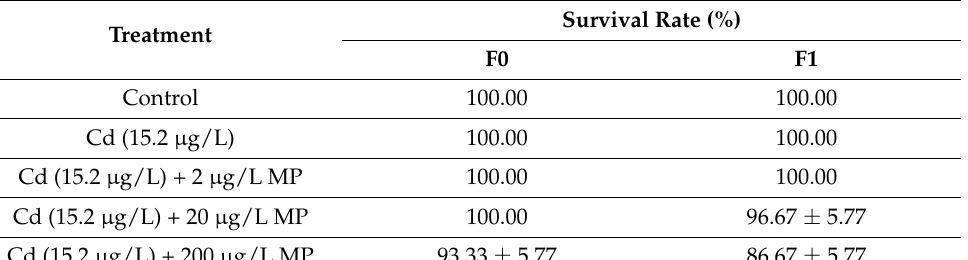
Table 1. Survival rate of T. japonicas in F0 and F1 generation exposed to Cd and PS-microplastic ( n = 10).